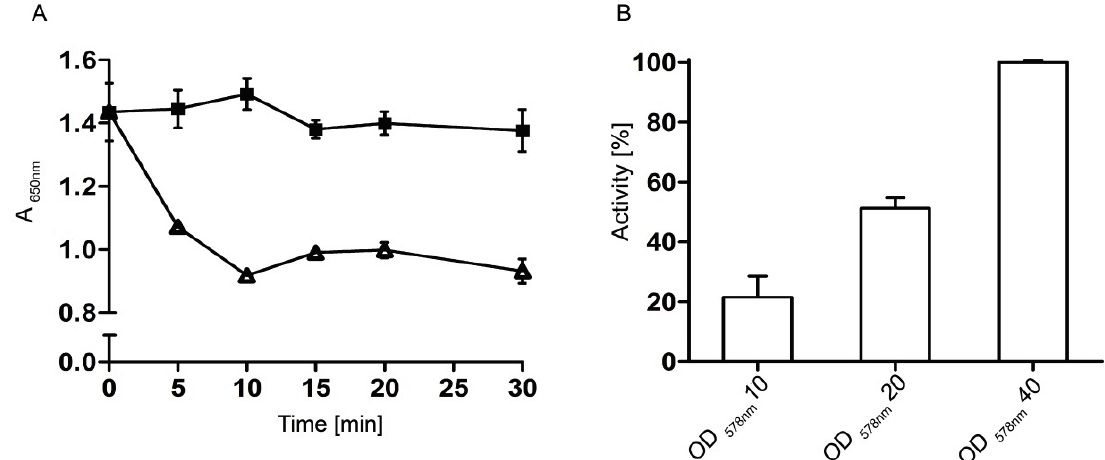
Figure 6. Optimal time ( A ) and cell density ( B ) for measuring the Hyal-1 activity displayed on E. coli F470; ( A ) Triangles: E. coli F470 pAK009 displaying Hyal-1; black